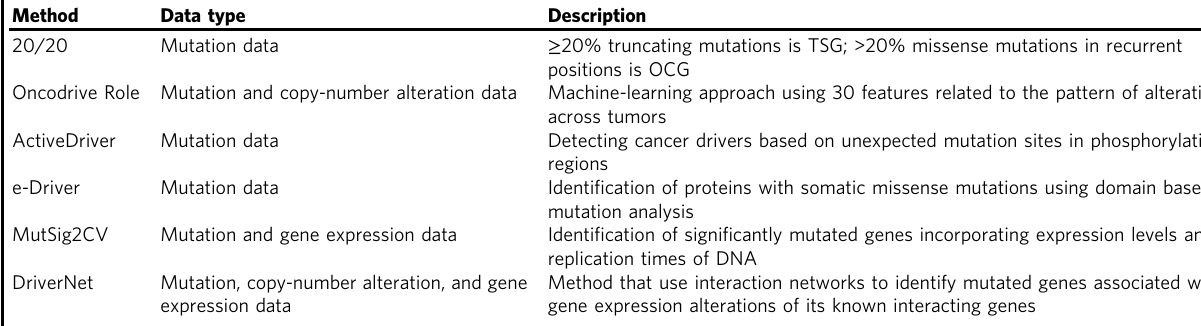
Table 1 Comparison of tools used to predict cancer driver